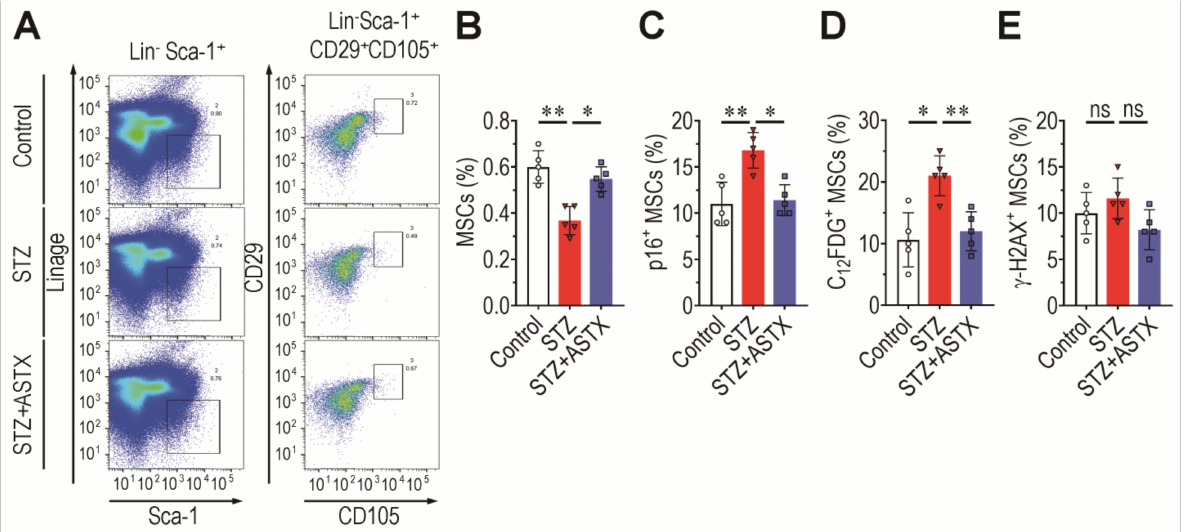
Figure 7. Supplemental ASTX inhibits hyperglycemia-mediated impairments in the BM MSCs of STZ-injected mice. ( A ) BM frequency of MSCs was determined by flow cytometry 60 days post- hyperglycemia induction, and ( B ) the mean percentage of these cells in mouse groups was calculated using FlowJo software ( n = 5/group). ( C , D ) Levels (%) of senescent MSCs in the BM of mouse groups were assessed using the senescence markers p16 INK4a and C 12 FDG on the same post-hyperglycemia day by flow cytometry ( n = 5/group). ( E ) γ -H2AX + MSC level in the BM of mouse groups was also measured by flow cytometry on the same post-hyperglycemia day ( n = 5/group). * p < 0.05 and ** p < 0.01 by unpaired Student’s t -test. ns, not significant.